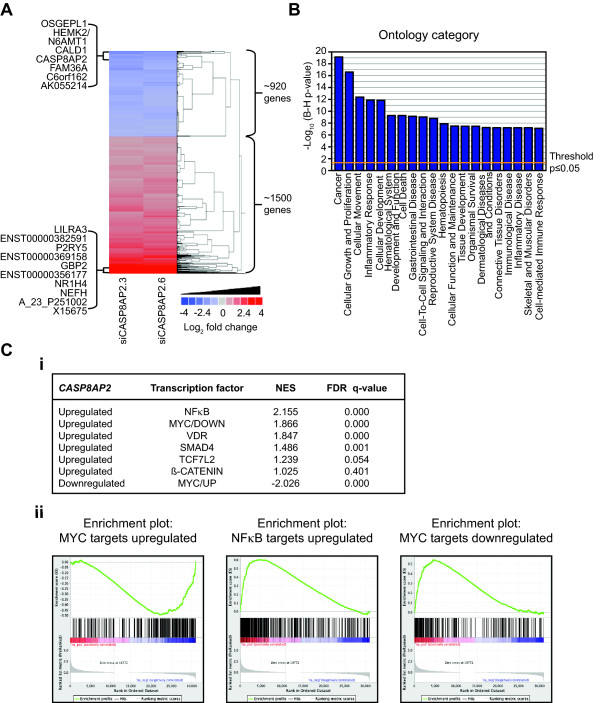
The CASP8AP2/FLASH RNAi signature. (A) Heat map representation of those genes showing a significant fold change (> ± 0.6 Log2 fold change, p < 0.05) 72 hours post transfection of two different siRNAs corresponding to CASP8AP2/FLASH. The 10 genes most altered in expression (up and down) following the silencing of CASP8AP2/FLASH are indicated. Median values are shown where multiple probes corresponding a specific gene were present. The probe corresponding to CASP8AP2/FLASH was the fourth most downregulated gene in the CASP8AP2 expression profile (ranked by changes mediated by siCASP8AP2.3 and then siCASP8AP2.6). The maximum fold changes in expression seen following the silencing of CASP8AP2/FLASH ranged from about a 2-fold linear decrease in expression to an over 20-fold increase in expression of over twenty genes. (B) The enrichment of functional ontologies for those genes upregulated following silencing of CASP8AP2/FLASH. No functional ontologies were significantly for those genes downregulated following CASP8AP2/FLASH loss of function. (C) Gene set enrichment analysis (GSEA) of the targets of transcription factors associated with CRC; (i) shows the overall statistical analysis for the enrichment of the targets within the CASP8AP2/FLASHRNAi signature for six transcription factors; NES refers to the normalized enrichment score, (ii) shows the enrichment plots for the targets of MYC and NFκB.